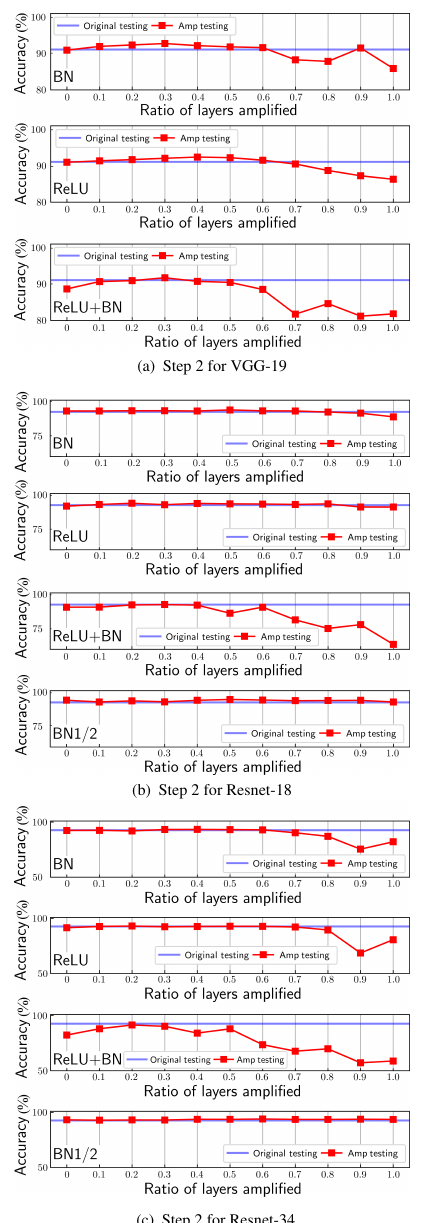
Fig. 4 Performance of the models after training with Step 2 strategy with gradient amplification (red) applied from epochs 51–100 compared to mean accuracies of the original models (blue) with no gradient amplification. In each plot, blue horizontal line shows the average testing accuracy of the original models without gradient amplification. Amp testing refers to testing accuracies of models with gradient amplification. The type of the layer is shown in each subplot; horizontal and vertical axes correspond to the ratio of amplified layers and accuracies, respectively. These experiment plots correspond to params S 2 0.3 xx, where the ratio (0.3) of layers are amplified for epochs 51–100. The other params S 2 0.1 xx, S 2 0.5 xx, and S 2 0.6 xx also have similar performance